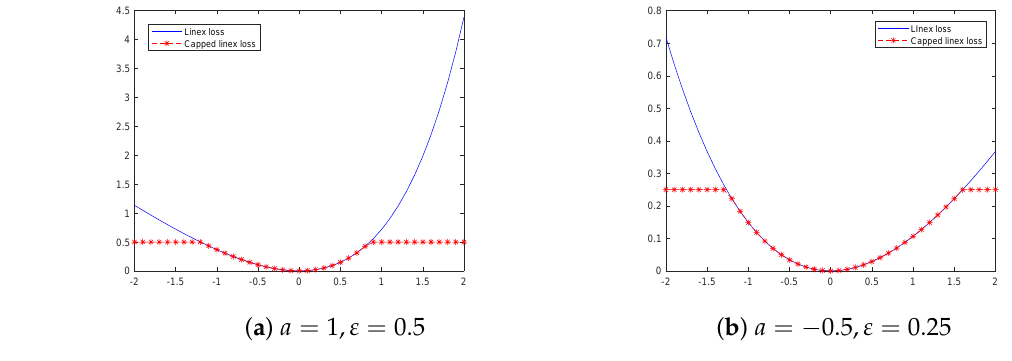
Figure 1. Linex loss capped linex